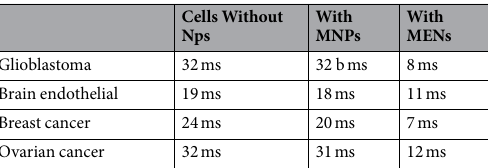
Table 1. Characteristic time constants for different cell-nanoparticle